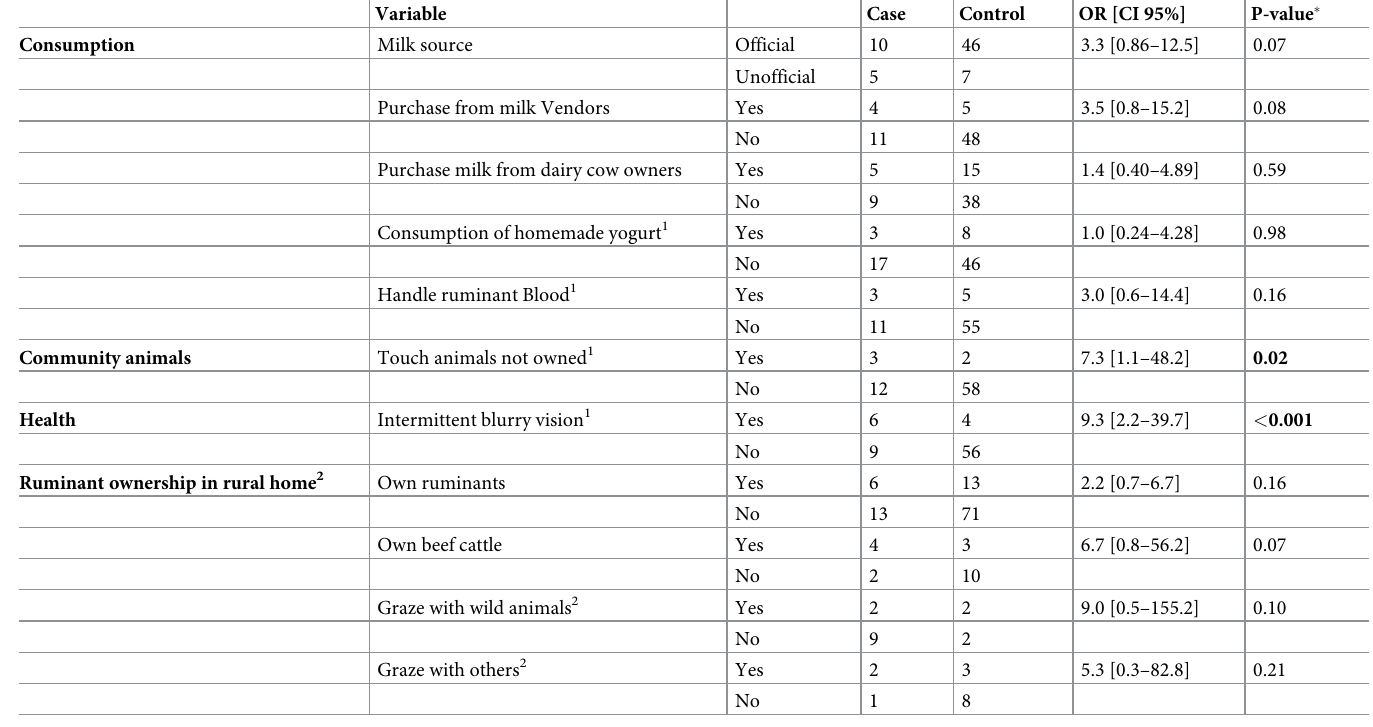
Table 3. Odds ratios to compare community animal exposures between cases and controls.